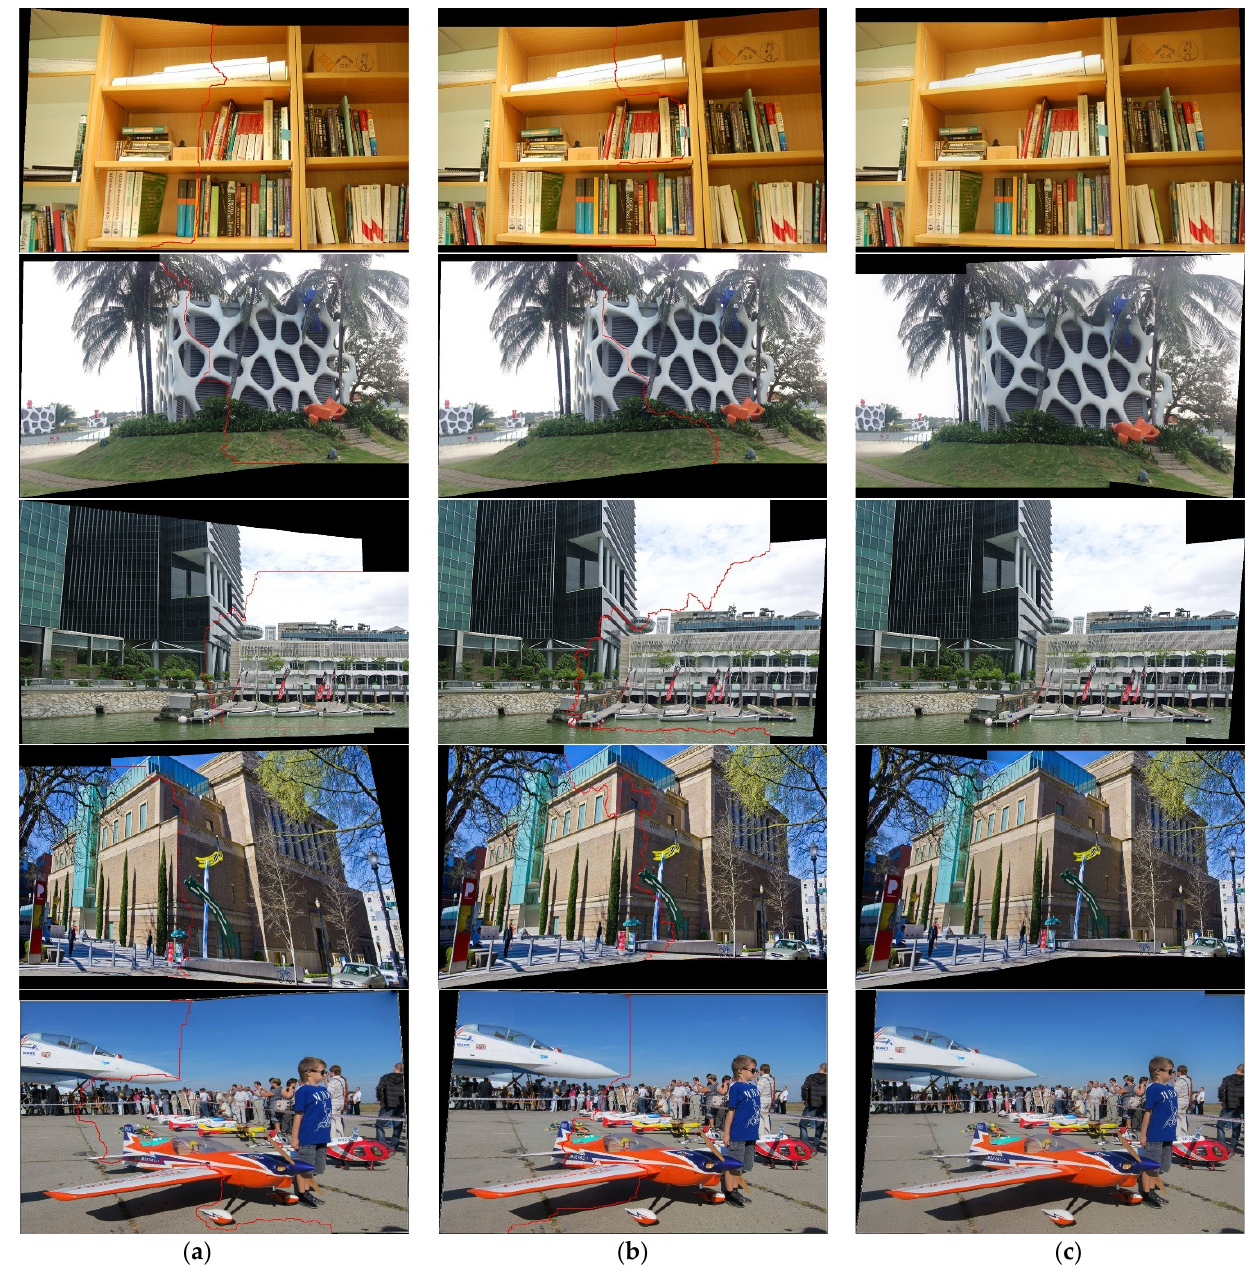
Figure 8. The image stitching results of different methods and the used seams. ( a ) The perceptual seam-cutting method in [18]. ( b ) The proposed method. ( c ) The final stitched image of SEAGULL dataset [17].